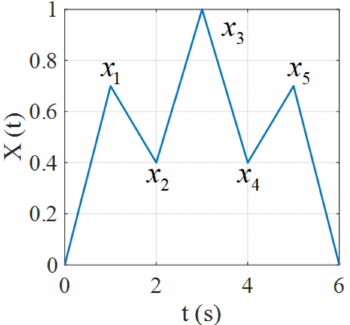
Figure 8. Input signal used in the validation of the congruency property.